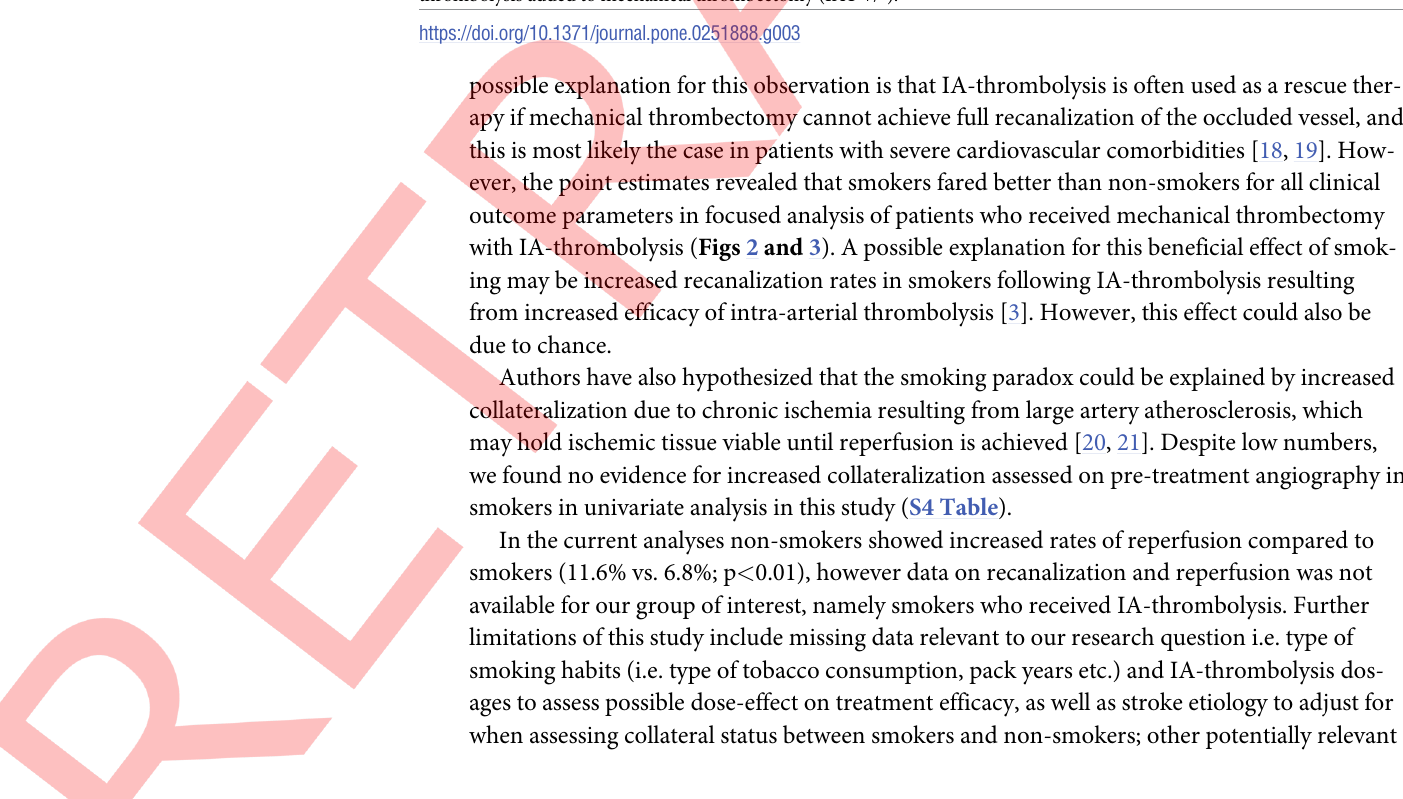
Fig 3. Modified Rankin Scale distribution. Distribution of scores on the modified Rankin scale (mRS) in percentages among patients receiving endovascular therapy, according to exposure variables (smoking +/-) and intra-arterial thrombolysis added to mechanical thrombectomy (IAT